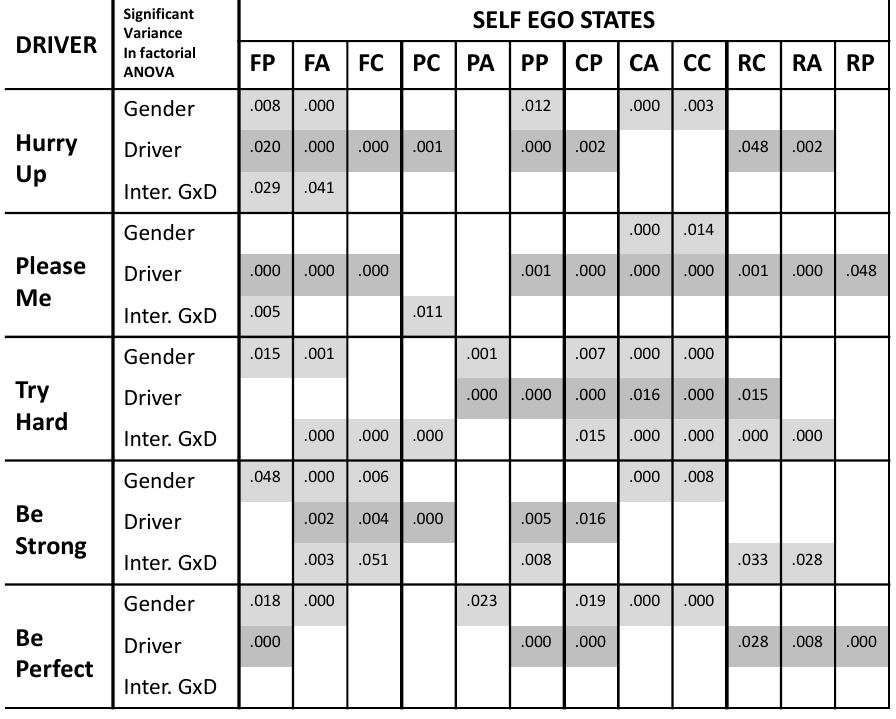
Table 1 – Summary of significant variance in factorial ANOVA from the five studies.